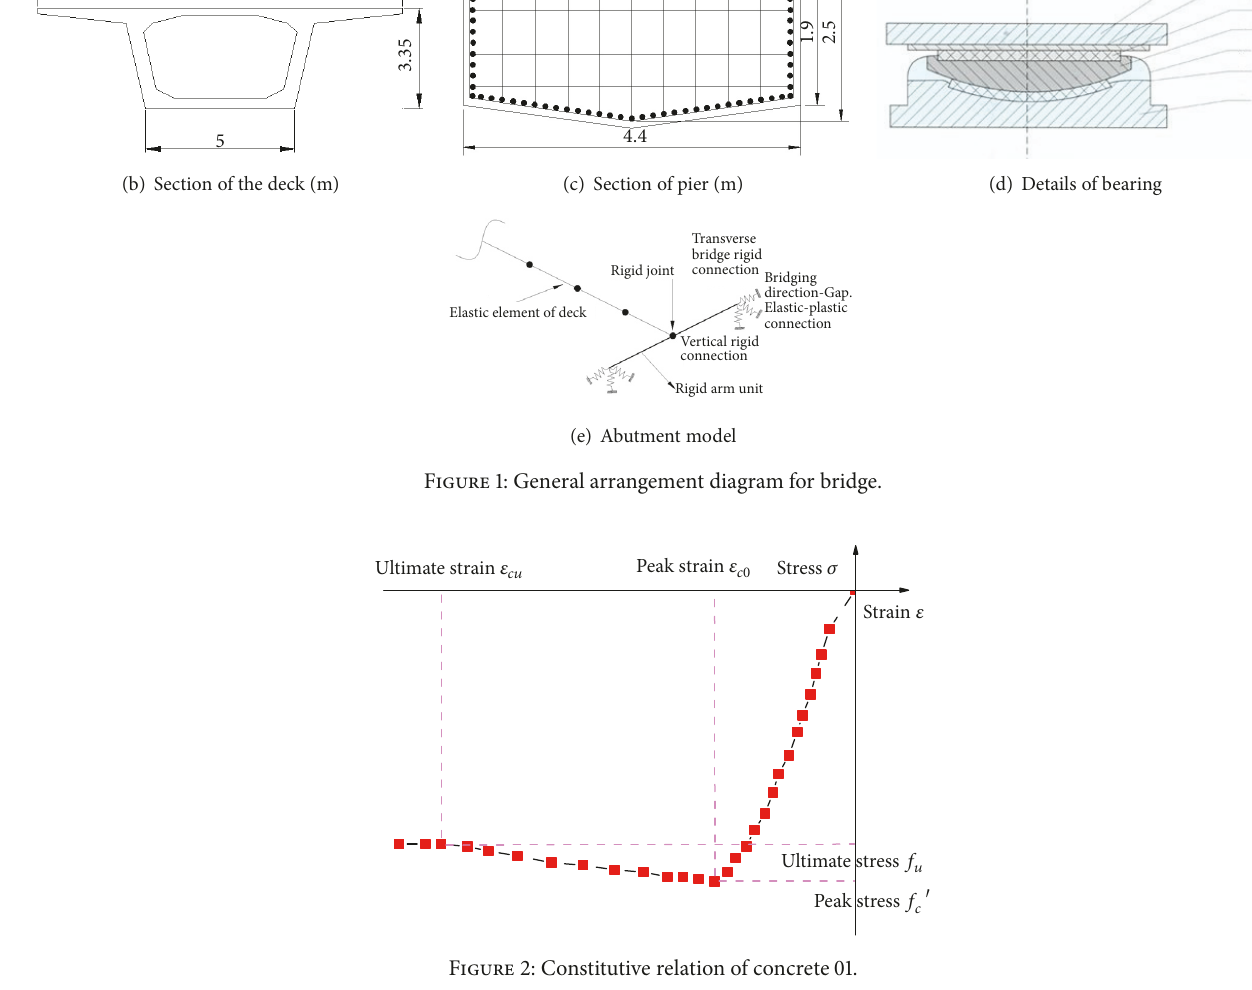
Figure 2: Constitutive relation of concrete